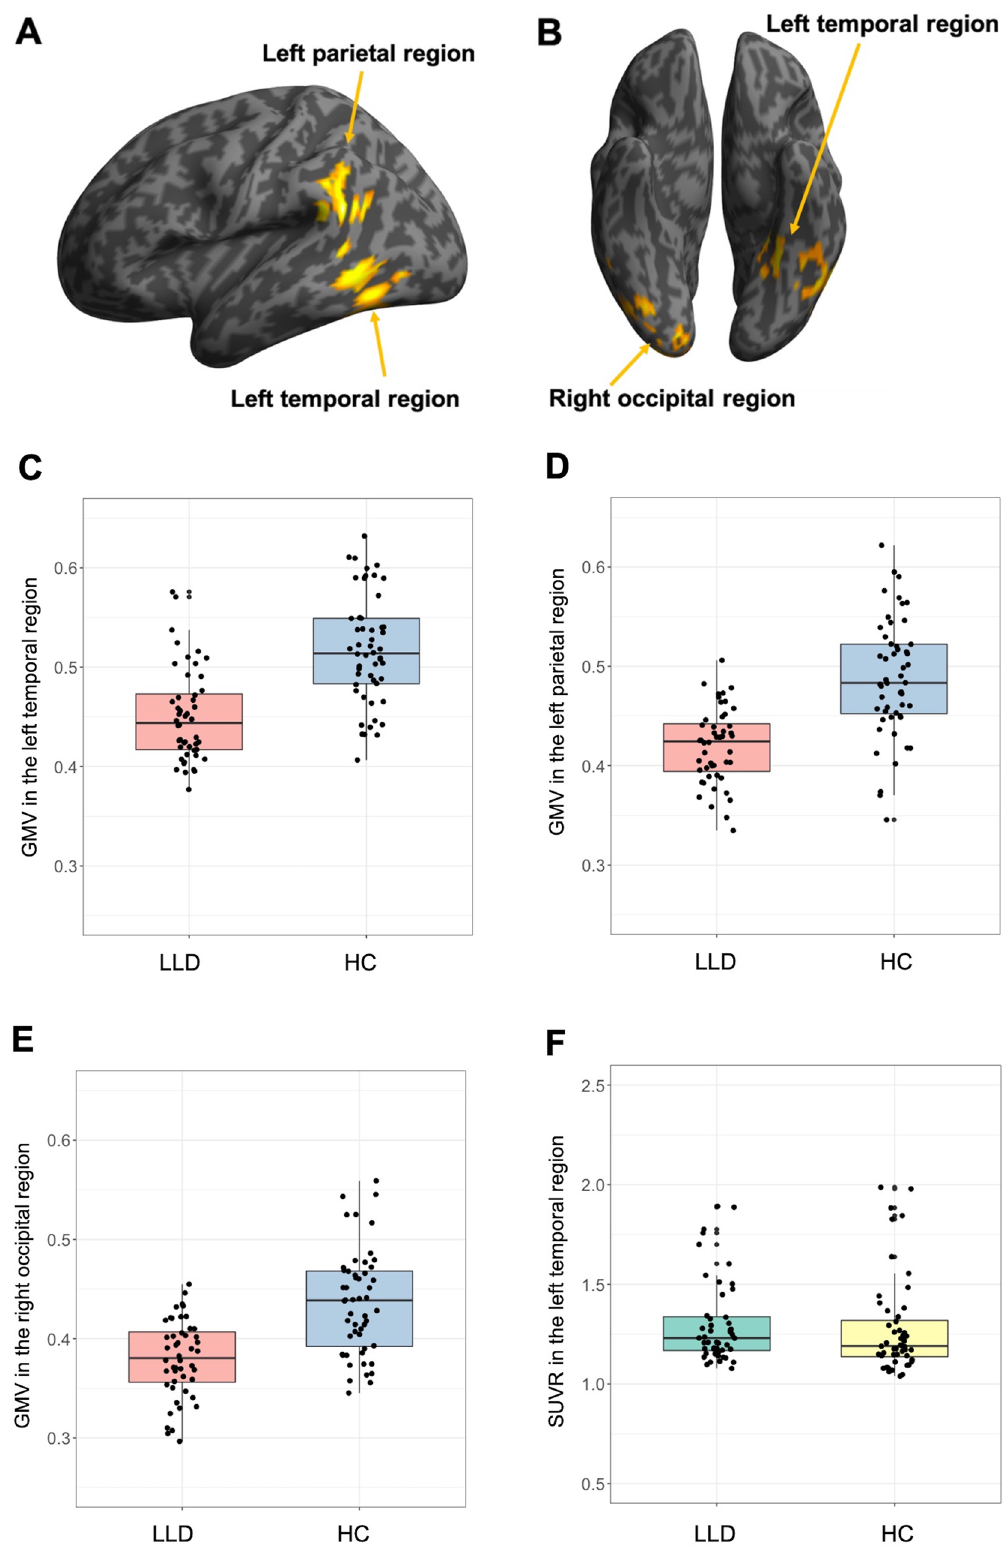
Figure 1. Brain regions showing significantly lower GMV in patients with late-life depression compared to healthy controls following whole-brain voxel-wise analysis. Three regions were identified: the left temporal, left parietal and right occipital regions. Areas associated with lower GMV in LLD are shown in yellow in ( A ) the left lateral view and ( B ) the bottom view. Boxplots of GMVs and SUVRs in each region are also presented: GMV in ( C ) the left temporal, ( D ) the left parietal, and ( E ) the right occipital regions; SUVR in ( F ) the left temporal region, ( G ) the left parietal region, and ( H ) the right occipital region. GMVs in these regions were significantly lower in LLD than in healthy controls ( C – E ), whereas SUVRs in these regions did not differ between groups ( F – H ). Y-axis represents mean voxel values in each cluster. HC healthy control, LLD late-life